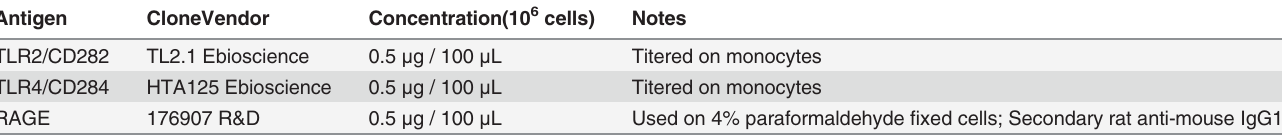
Table 2. Antibodies used to examine surface expression of HMGB1 receptors on human eosinophils.